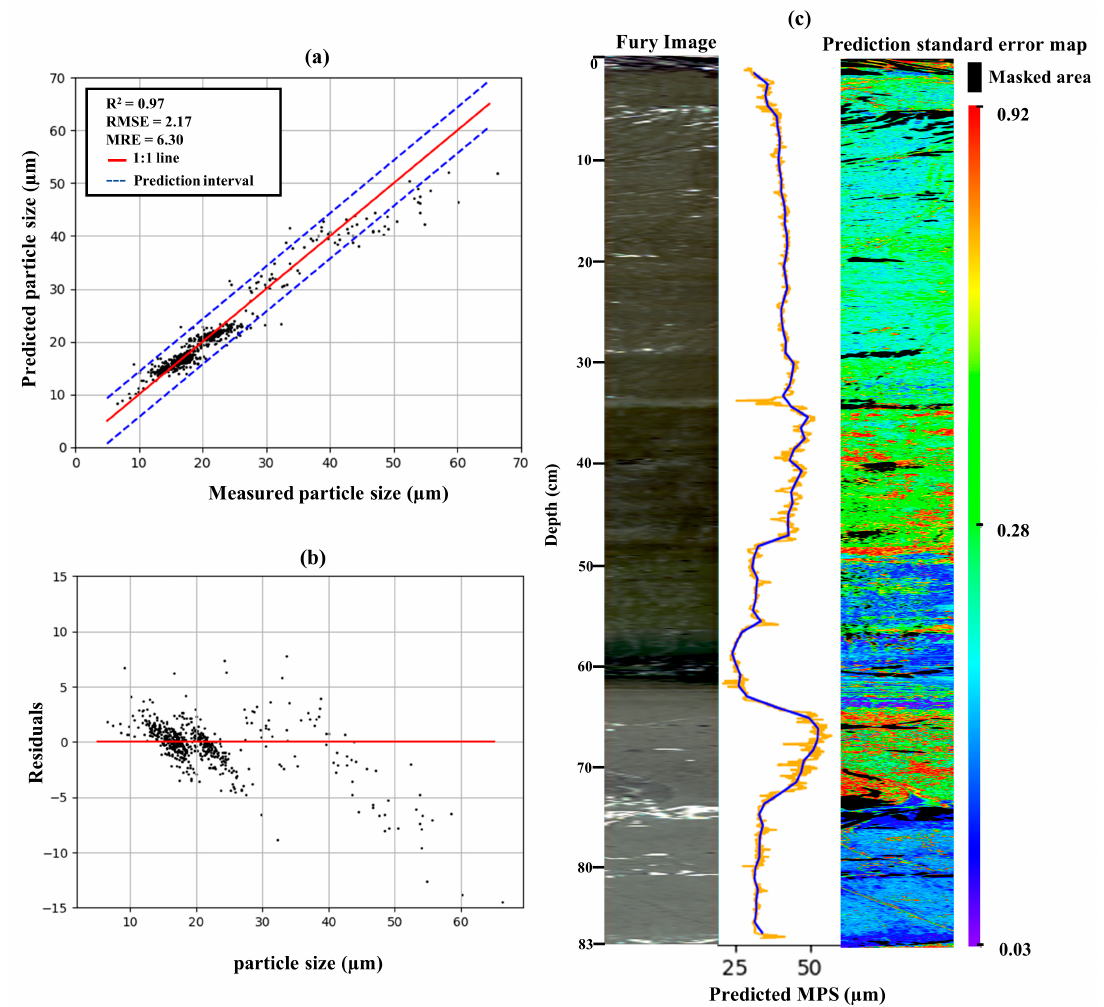
Figure 7. Ensemble scatter plots of ( a ) measured versus predicted particle size, and ( b ) residuals of the predicted particle sizes. ( c ) Graphical representation of predicted mean particle size (MPS) for Fury dataset and equivalent prediction standard error map (middle diagrams; orange line: high-resolution MPS profile; blue line: one-centimeter averages).